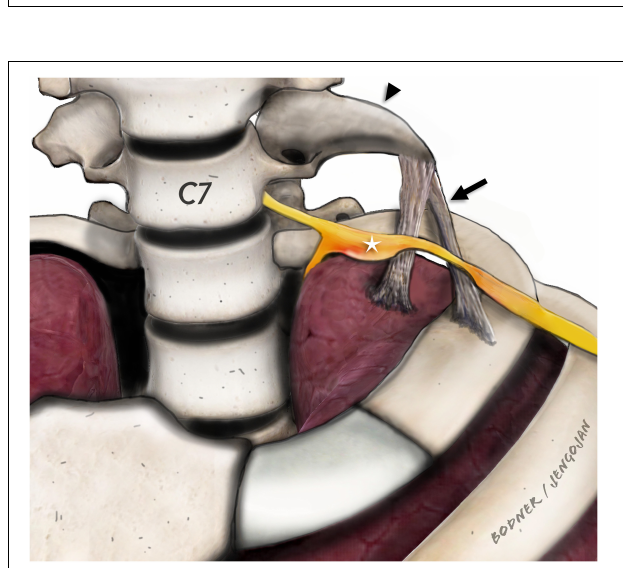
FIGURE 2 | Para-sagittal/para-coronal illustration of the stump rib (black arrowhead) and the fibrous ligaments (black arrow). Adjacent to the tip of the stump rib (C7), the fibrous ligaments are drawn which extend either to the first rib or to the pleural cupula as described by Emil Zuckerkandl. The inferior brachial plexus (C8 and T1) components (white star) are displaced and enlarged with obvious constriction at the direct level of the crossing fibrous ligaments. In our study, we only detected ligaments extending to the pleural cupula.